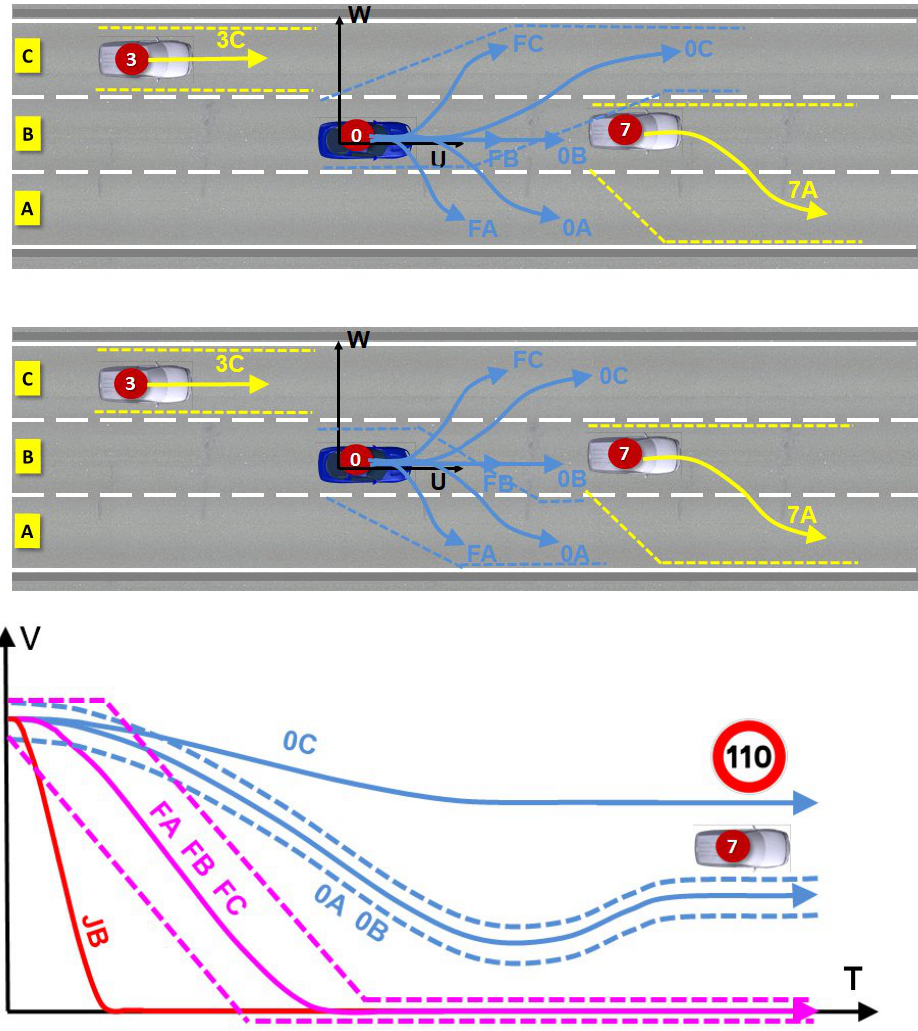
Figure A6. Generation of the seven speed profiles (normal, failure, emergency braking) for the